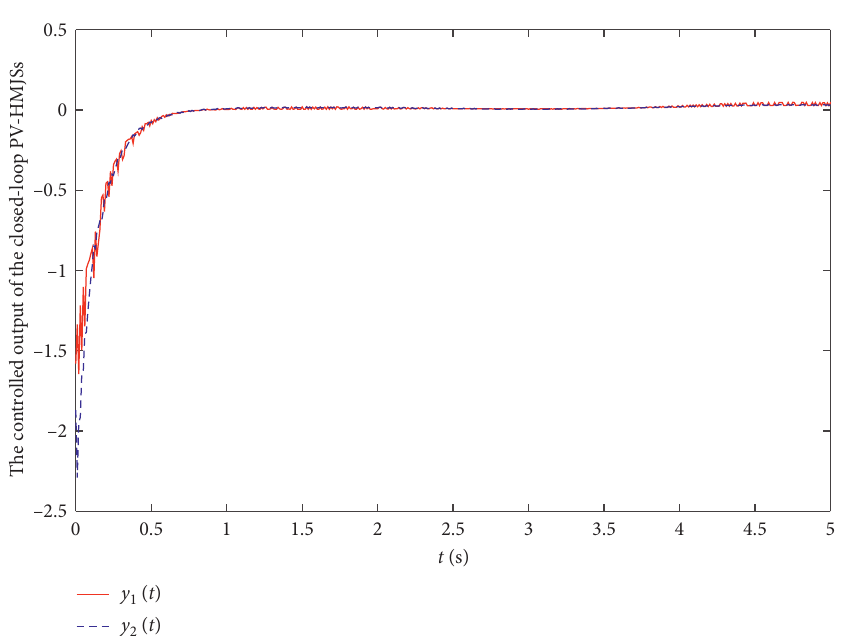
Figure 3: The y ( t ) of the closed-loop